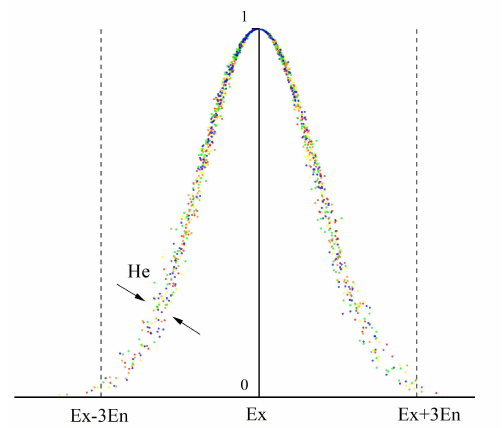
Figure 8. Cloud-model digital features